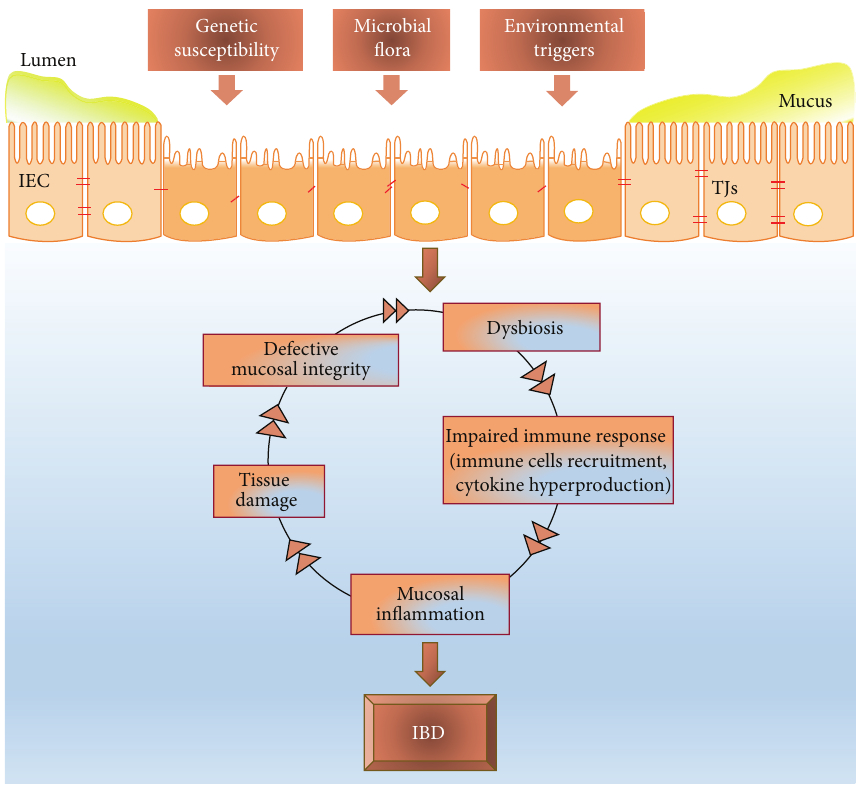
Figure 1: The pathogenesis of IBD. Genetic, microbial, and environmental factors participate to disrupt the intestinal barrier. The defective mucosal integrity starts a complex vicious cycle that leads to, enhances, and perpetuates